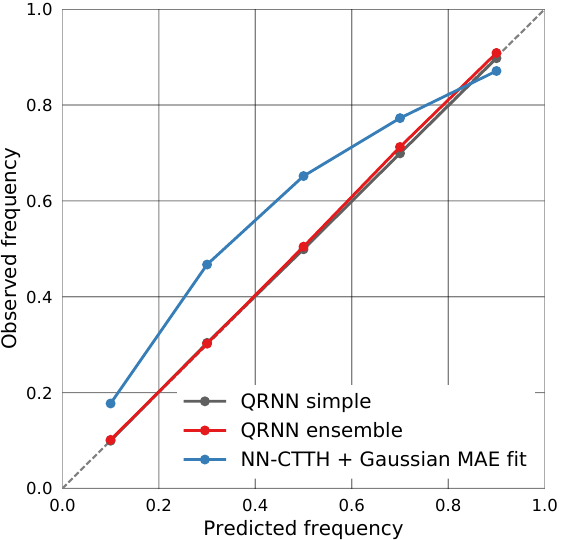
Figure 13. Calibration of the prediction intervals obtained from NN-CTTH (blue) and a single QRNN (red) with respect to specific cloud